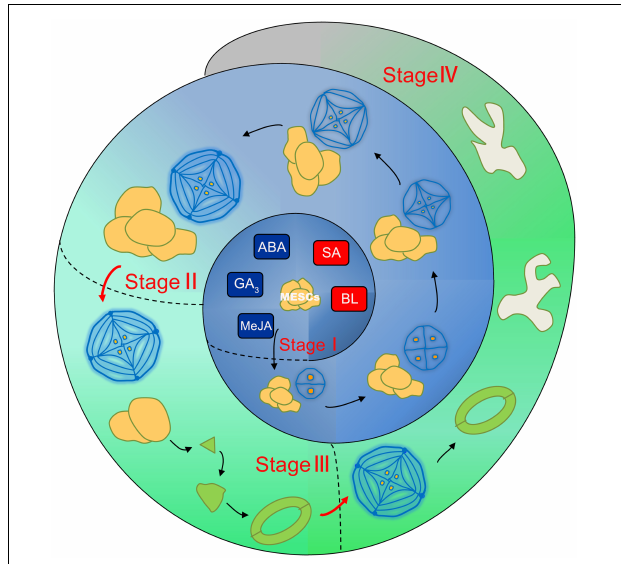
Supplementary Figure 1 | Salt gland density of the first true leaf under different hormone